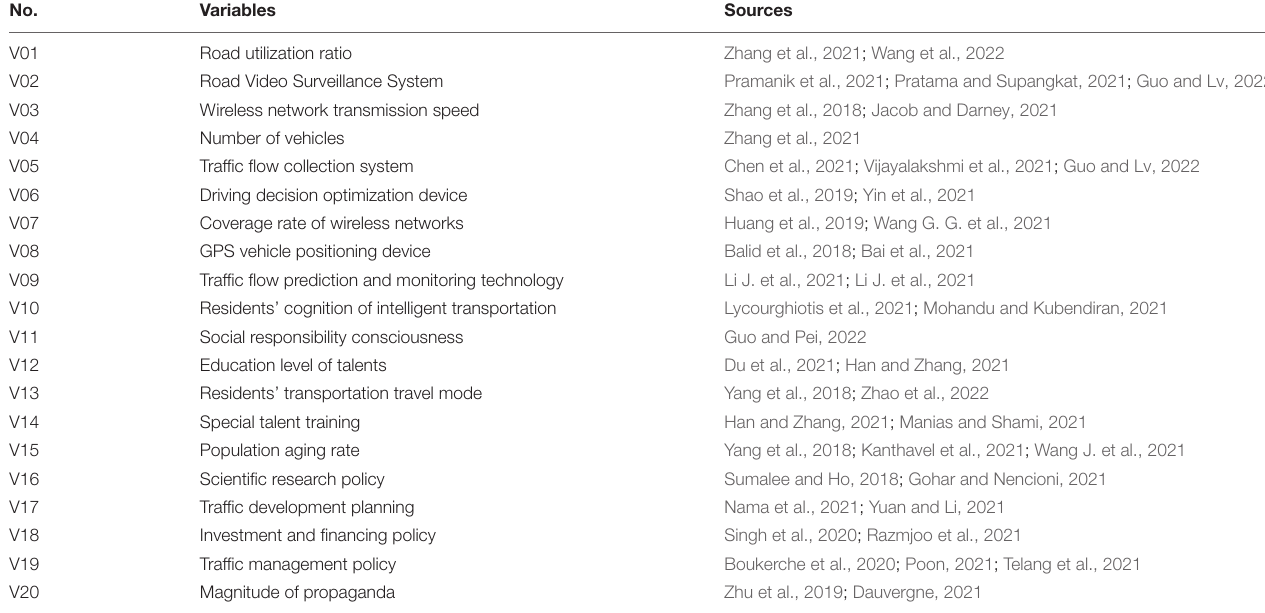
TABLE 1 | The sources of the variables.